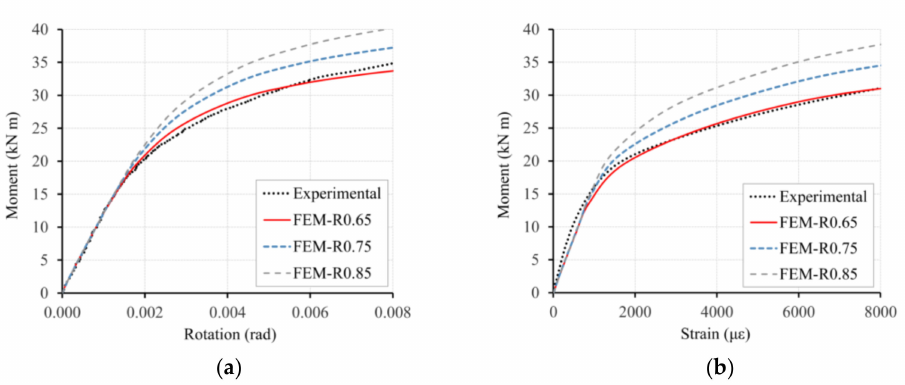
Figure 12. Comparison between experimental and numerical results of the non-strengthened connec- tion. ( a ) Moment-rotation. ( b ) Moment-strain.